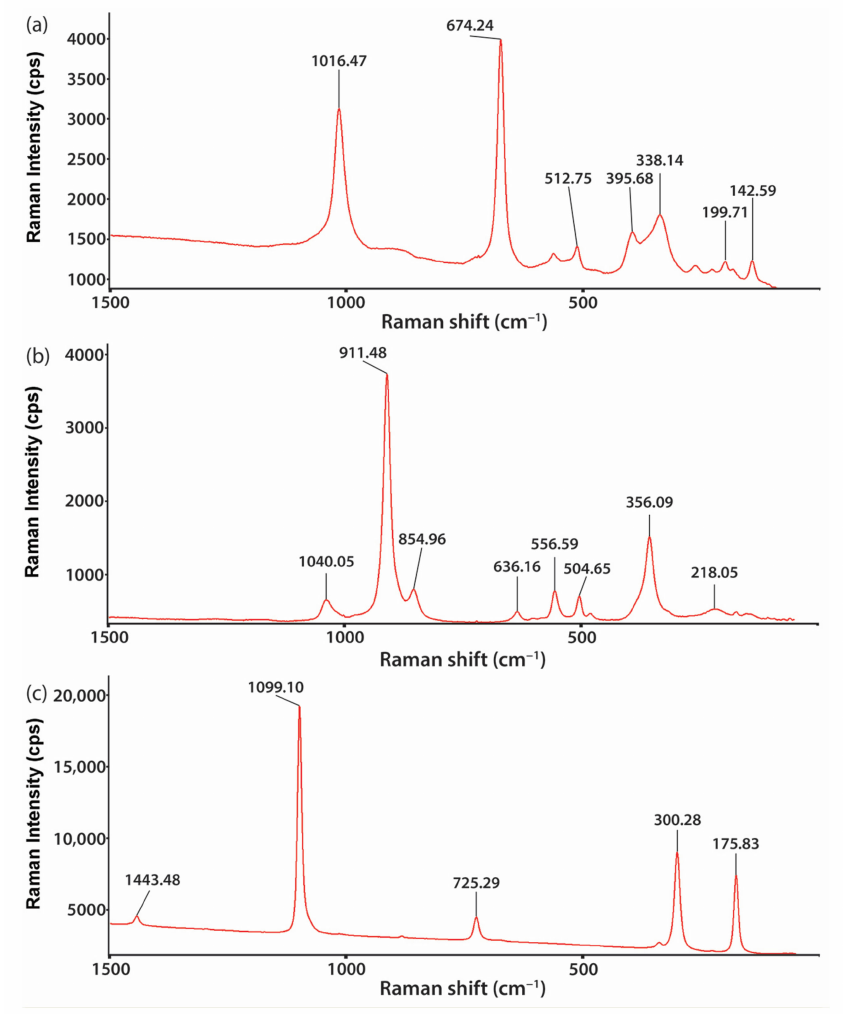
Figure 4. Micro-Raman spectra of ( a ) omphacite, ( b ) garnet, and ( c ) zircon in sample